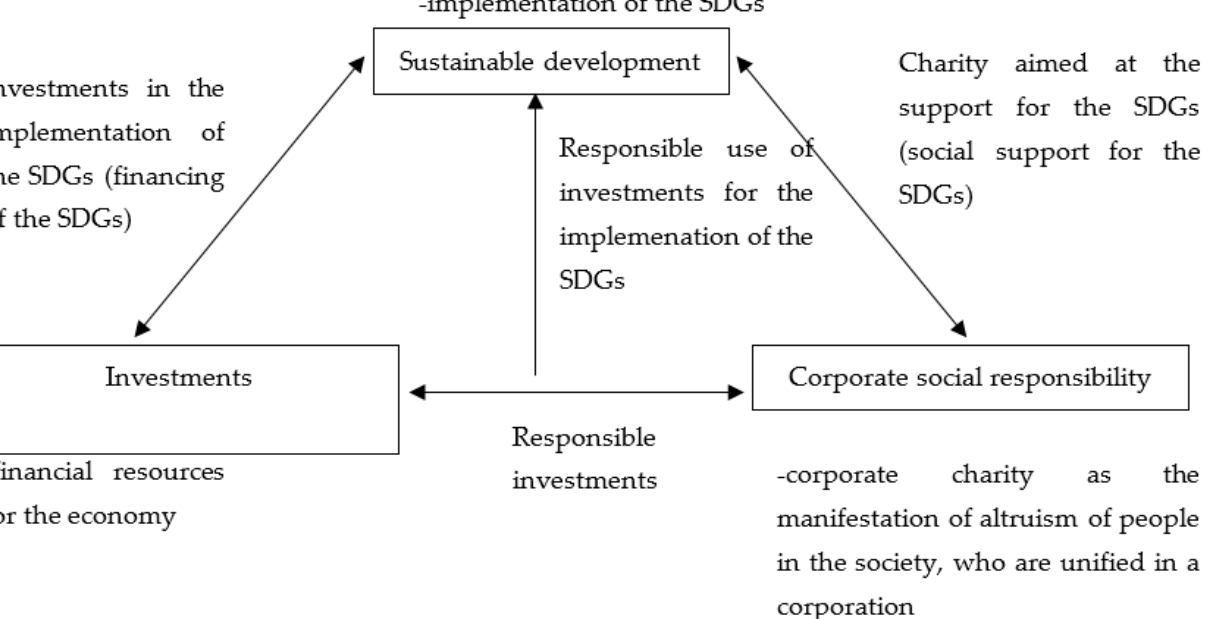
Figure 1. The theoretical connection between sustainable development, corporate social responsibility, and investments is the logical basis of this paper. Source: authors.